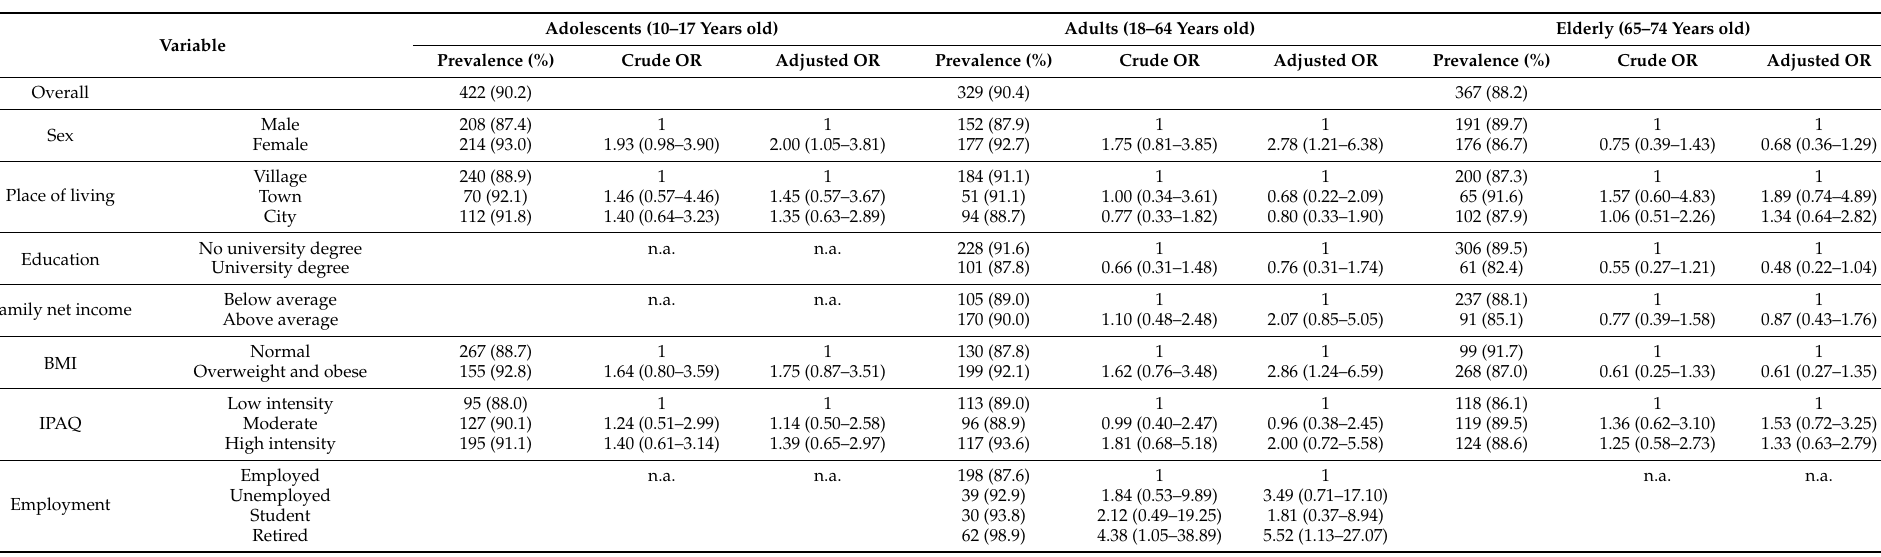
Table 3. Association between prevalence of inadequate daily intake of dietary fibre (<30 g/day) and sex, place of living, education, family net income, BMI, IPAQ, employment for diferent age